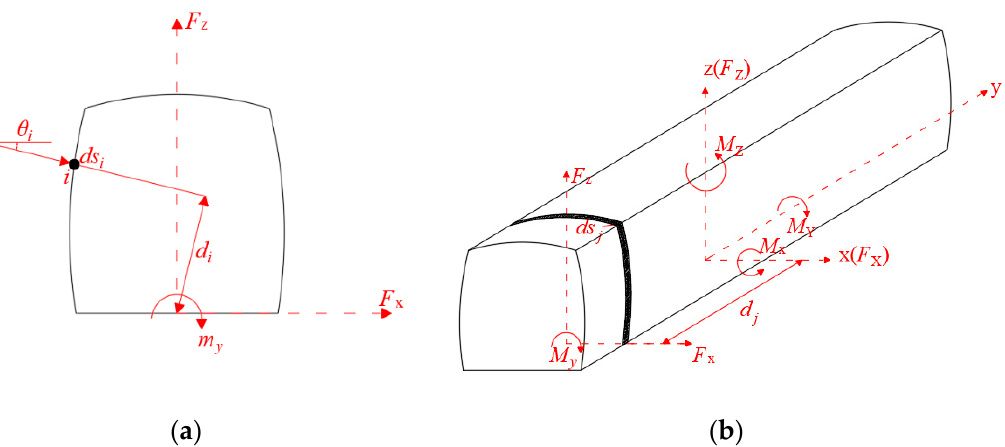
Figure 9. Definitions of force coefficients. ( a ) Definitions of sectional force coefficients; ( b ) Definitions of total force coefficients.